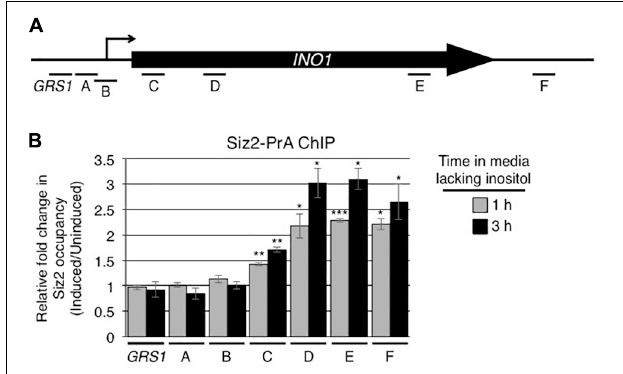
FIGURE 3 | Induction of INO1 is accompanied by recruitment of Siz2 to the INO1 locus. (A) Diagram of the INO1 locus and regions detected by ChIP analysis (see Figure 1A ) in B . (B) Cells expressing protein A tagged Siz2 (Siz2-PrA) were grown as described in the Figure 1 legend, and harvested at 0, 1, and 3 h after INO1 induction. Changes in Siz2-PrA occupancy along the INO1 locus following induction were examined by ChIP and qRT-PCR using primer pairs that amplify regions of INO1 indicated in A . Relative fold change in Siz2-PrA binding was determined as described for SUMO binding in Figure 1 . Results are the means ± SEM of at least three biological replicates. Asterisks indicate a significant difference relative to uninduced as determined by a Student’s paired t -test. * p < 0.05, ** p < 0.01, *** p < 0.001.